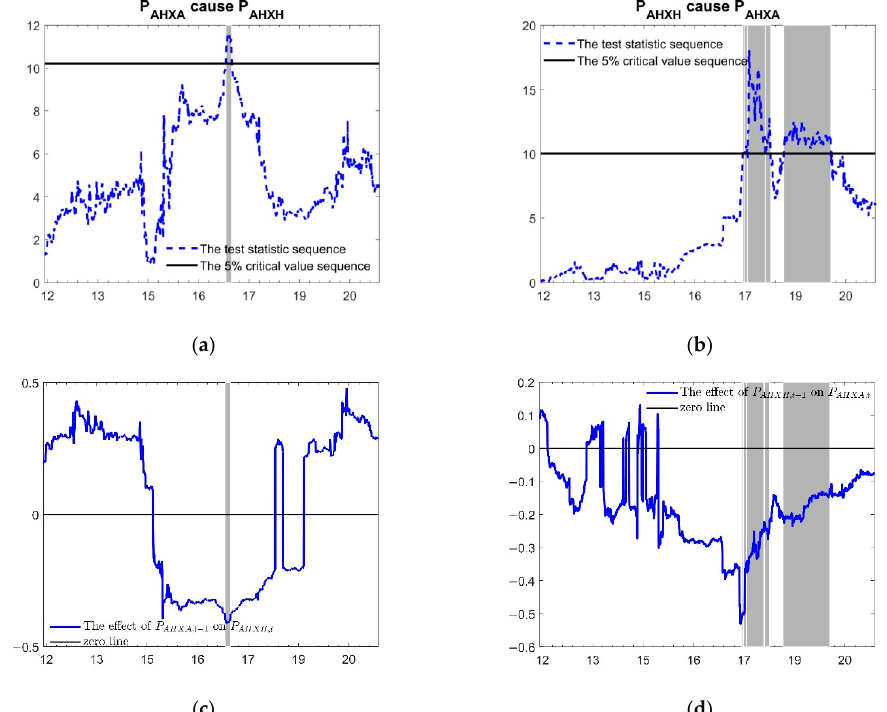
Figure 2. Time varying causalities between AHXA and AHXH at price level. ( a ) Graphical results of whether AHXA P is a cause of AHXH P ; ( b ) Graphical results of whether AHXH P is a cause of AHXA P whether P AHXA is a cause of P AHXH ; ( b ) Graphical results of whether P AHXH is a cause of P AHXA ; ; ( c ) The effect of lag-term AHXA P on AHXH P ; ( d ) The effect of lag-term AHXA P on AHXH P .